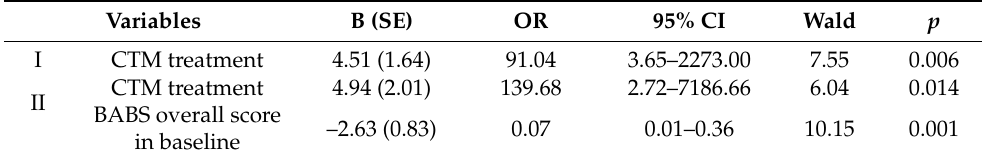
Table 4. Results analysis by multinomial logistic